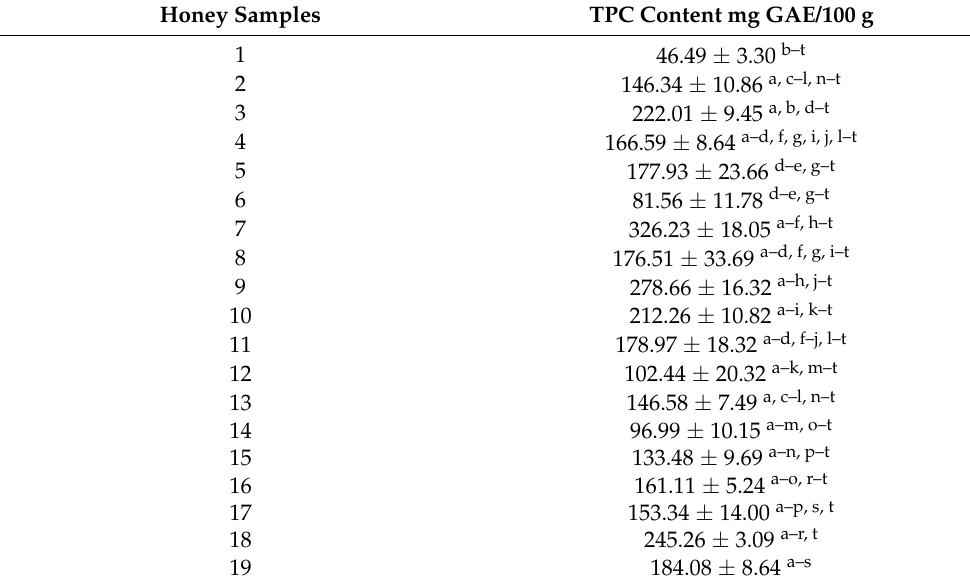
Table 2. Total phenolic compound content (TPC) of the honeys analysed. Honey